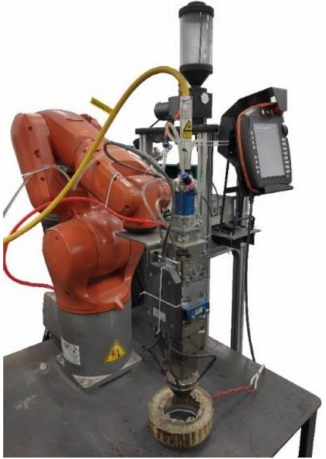
Figure 2. Experimental